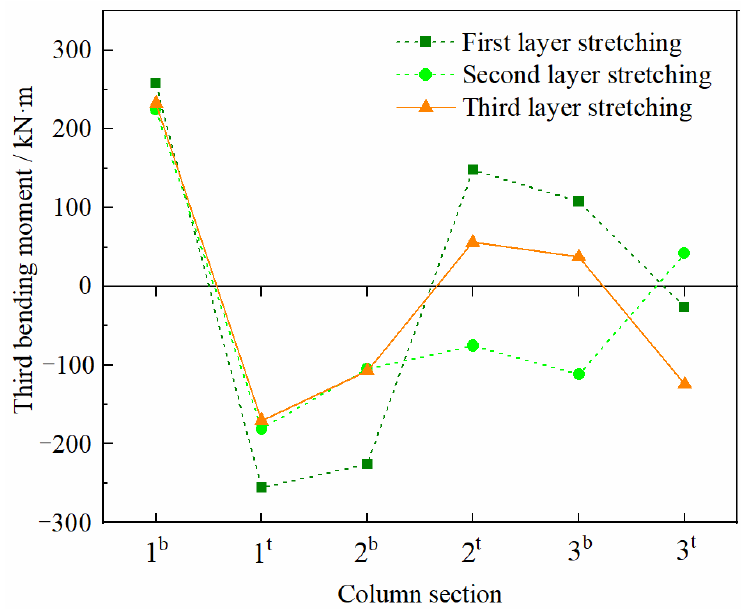
Figure 13. The third moment of the several-layer stretching plan. (Note: number in horizontal coordinates indicates layer number, “b” refers to column bottom section, “t” refers to column top section.)